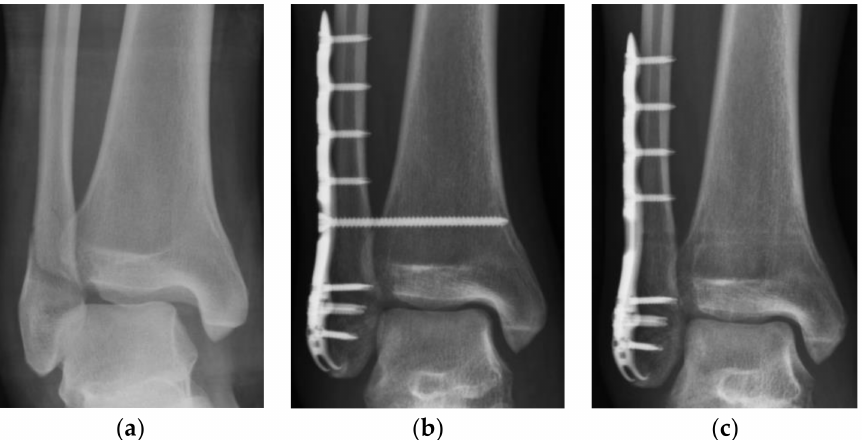
Figure 2. Demonstration of serial images evaluation: ( a ) Patients who met the inclusion criteria were collected; ( b ) pre-SR anteroposterior radiographs were obtained; ( c ) last-FU anteroposterior radiographs were obtained. CS: tibiofibular clear space; last-FU: last follow-up; OL: tibiofibular overlap; pre-SR: presyndesmotic screw removal.